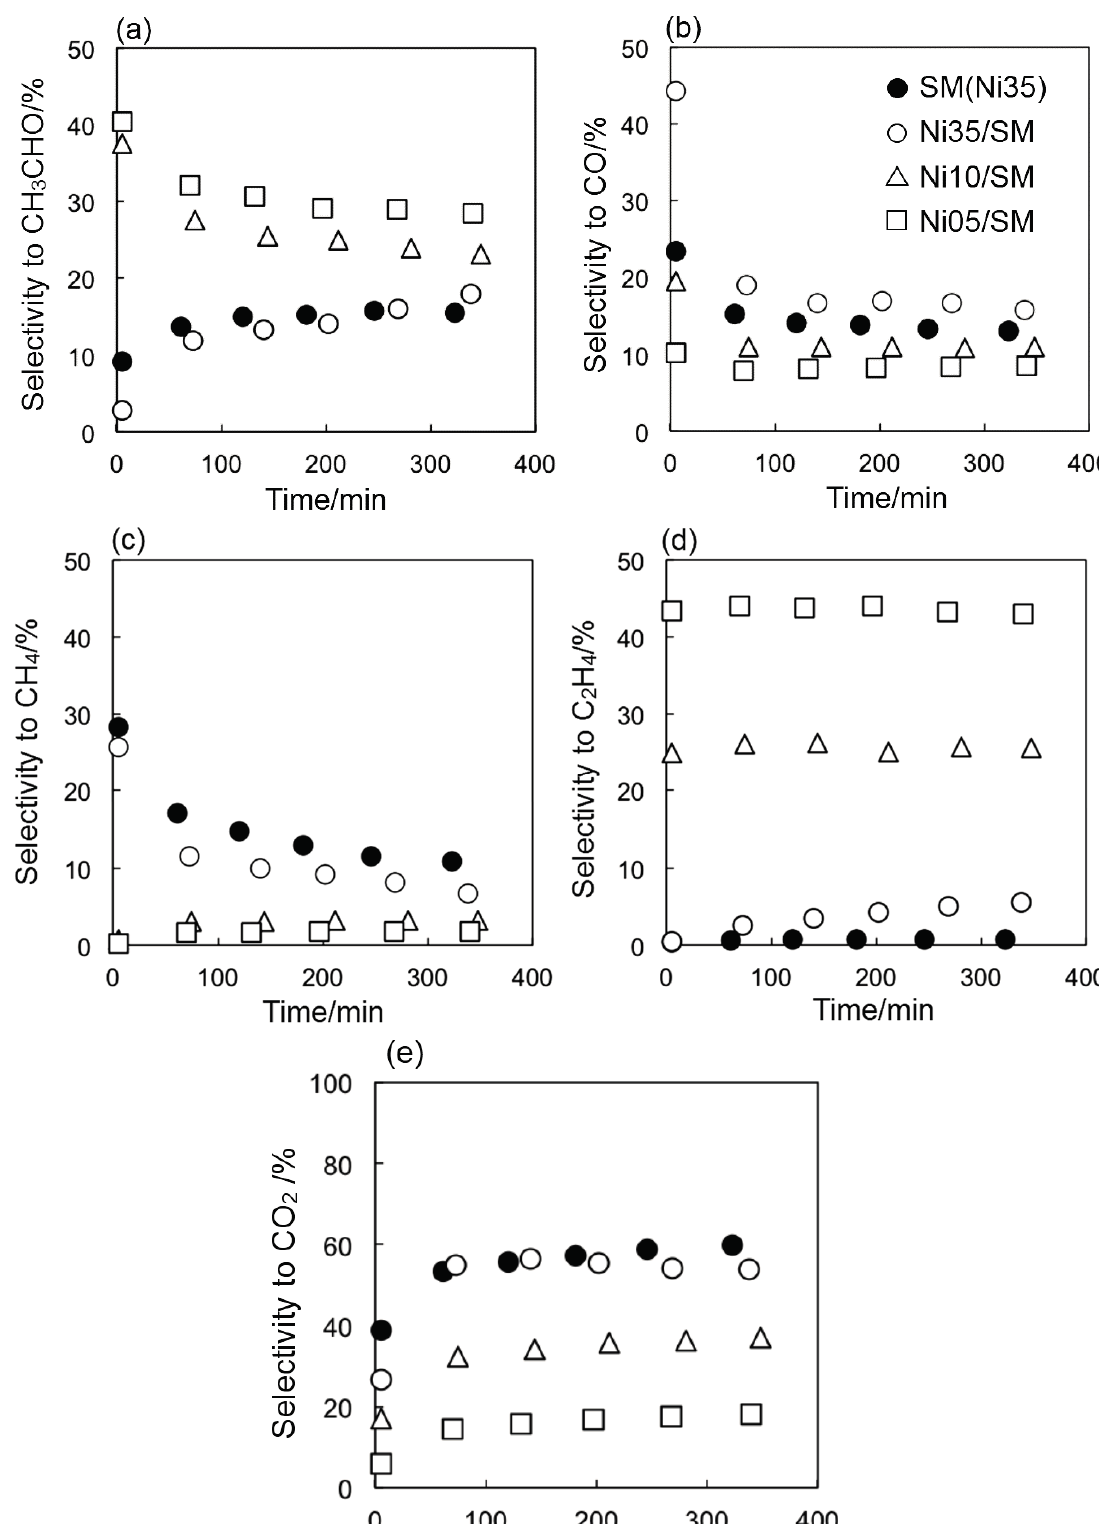
Figure 7. Time profiles of selectivity to CH 3 CHO ( a ); CO ( b ); CH 4 ( c ); C 2 H 4 ( d ) and CO 2 ( e ) over different Ni catalysts given at 500